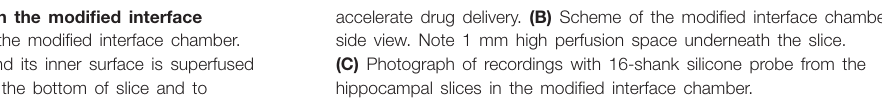
(C) Photograph of recordings with 16-shank silicone probe from the hippocampal slices in the modified interface